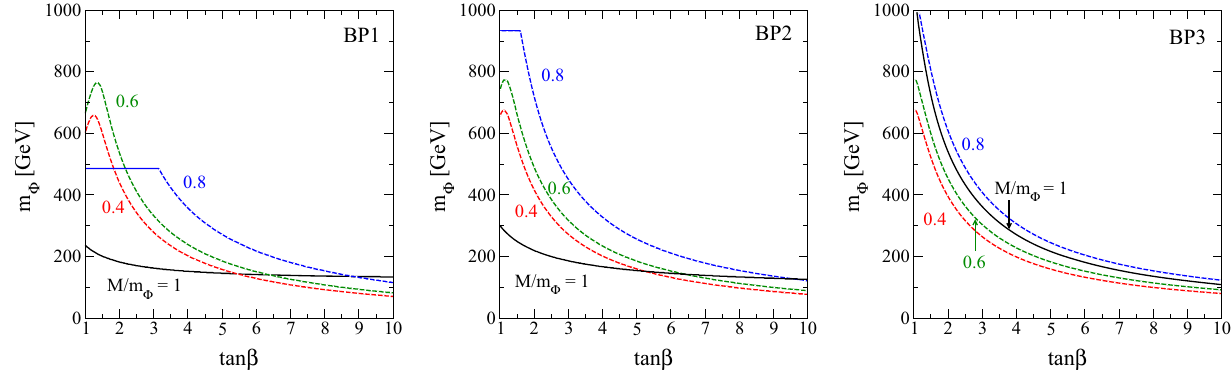
= m = m ) tan β in BP1 ( left ), BP2 ( center ) and BP3 ( right ). We take several fixed A H H ± values of the ratio M / m (cid:8) and